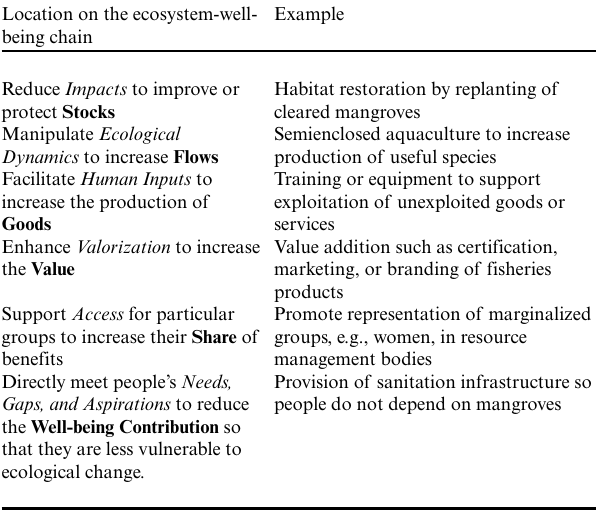
Table 4 . Interventions to improve well-being suggested by the ecosystem-well-being chain conceptual